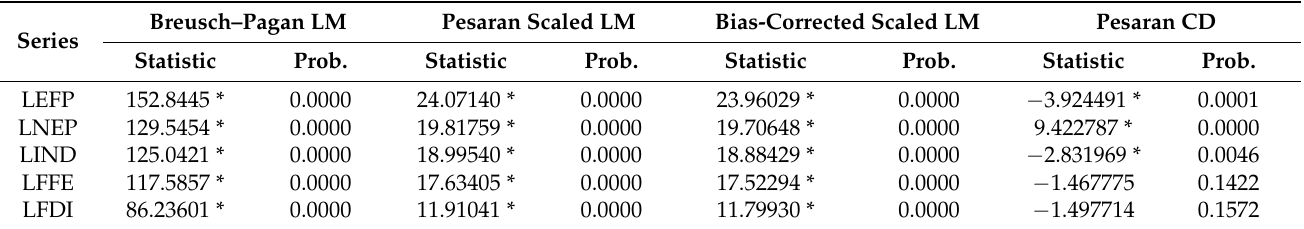
Table 4. Cross-section dependence